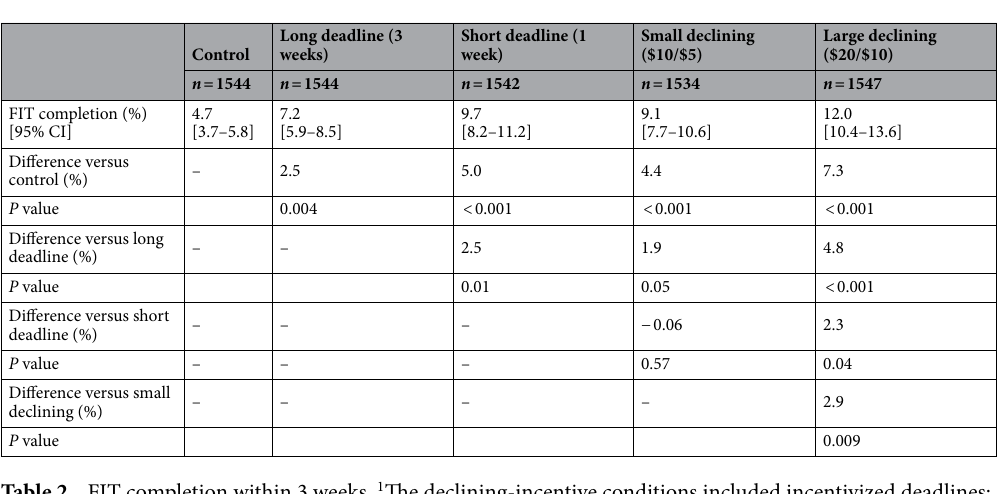
Table 2. FIT completion within 3 weeks. 1 The declining-incentive conditions included incentivized deadlines: small declining incentive ($10 for completion within 1 week or $5 for completion within 3 weeks) and large declining incentive ($20 for completion within 1 week or $10 for completion within 3